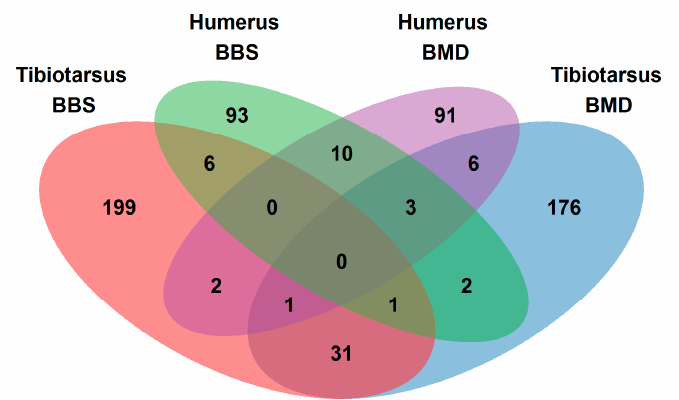
Figure 2. Venn diagram showing the overlap of genes for the bone breaking strengths (BBS) and bone mineral densities (BMD) of the tibiotarsus and humerus.